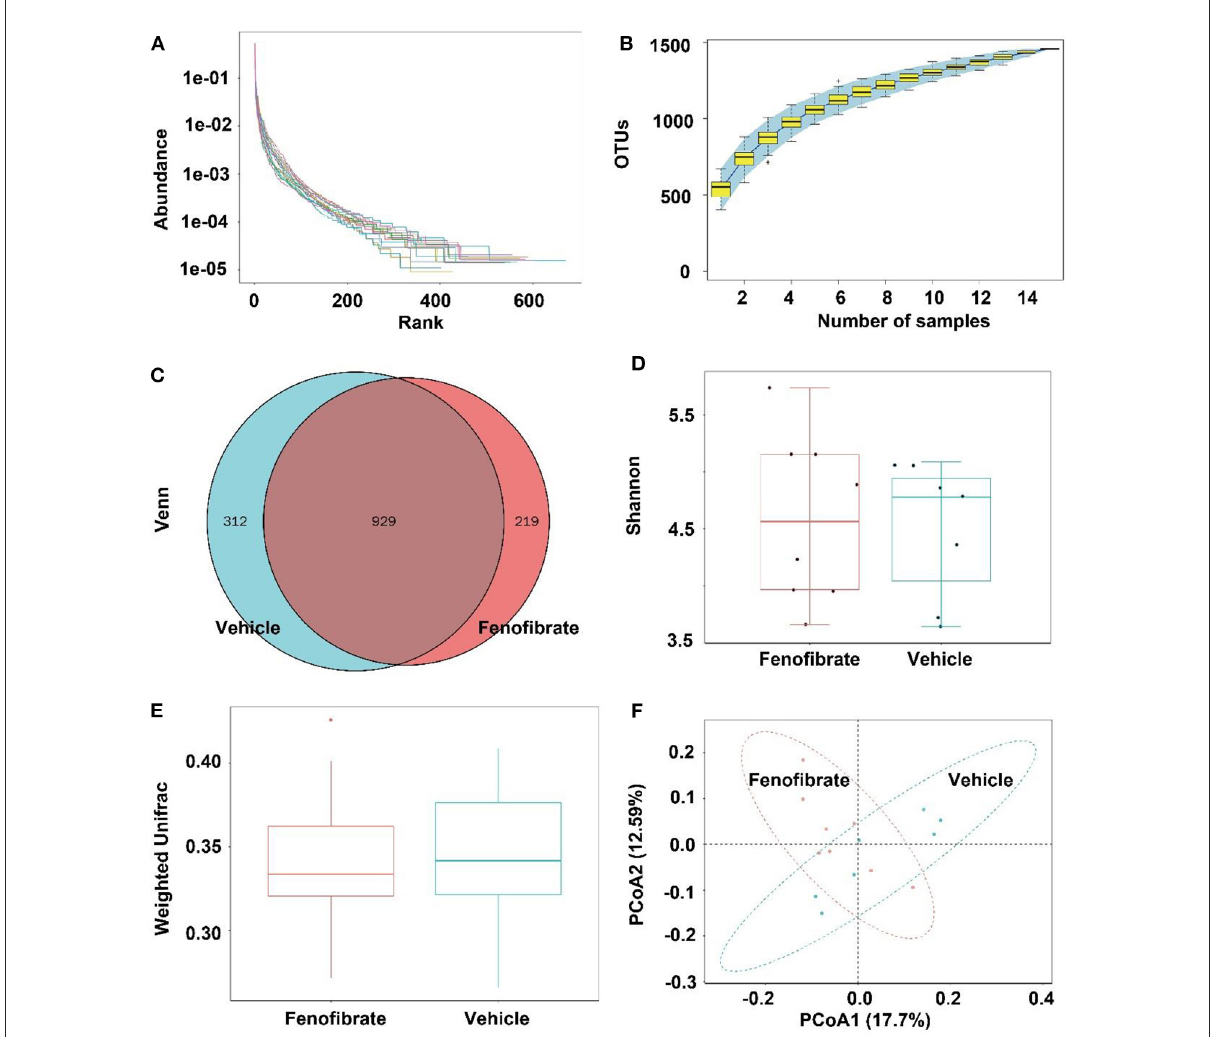
FIGURE6 Effect of fenofibrate on the gut microbiota of the ob/ob mice. (A) rank-abundance curves; (B) species accumulation curves; (C) OTU Venn graph; (D) α diversity (Shannon graph); (E) β diversity (Weighted Unifrac); (F) principal co-ordinates analysis. Vehicle: mice were treated with 0.5mL of water by gavage for 13 weeks ( n = 7); Fenofibrate: mice were treated with 0.5mL of fenofibrate suspension liquid at the dose of 20 mg/kg/d by gavage for 13 weeks ( n =